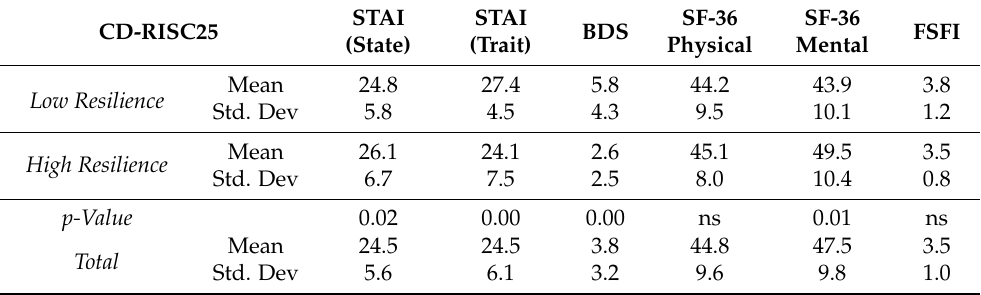
Table 4. Mean scores of psychometric scales according to the level of resilience using CDRISC-25. Low resilience: scores below the first quartile (Q1: 59.75). High resilience: scores higher than the third quartile (Q3: 80.25).